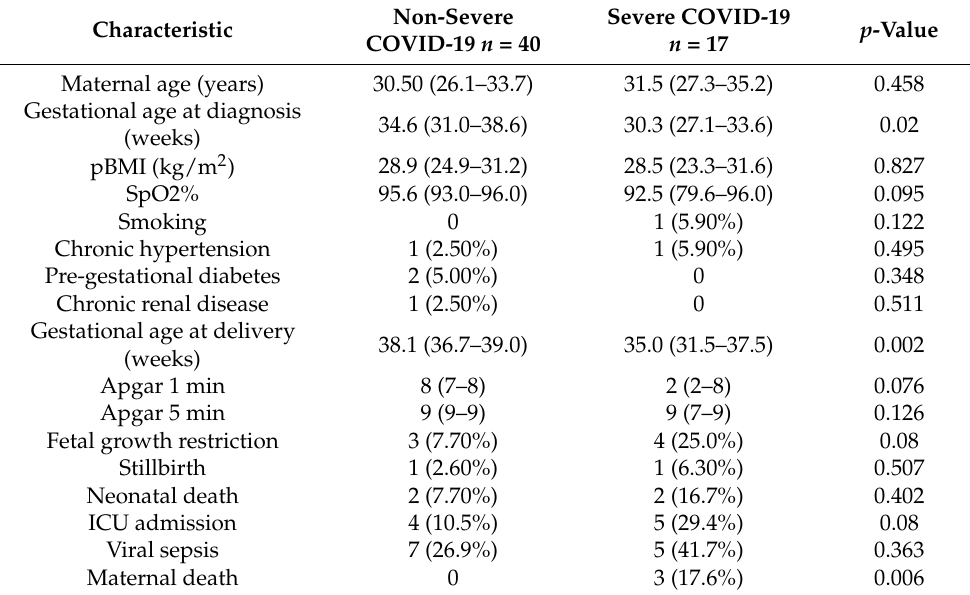
Table 1. Clinical characteristics of COVID-19 pregnant women.